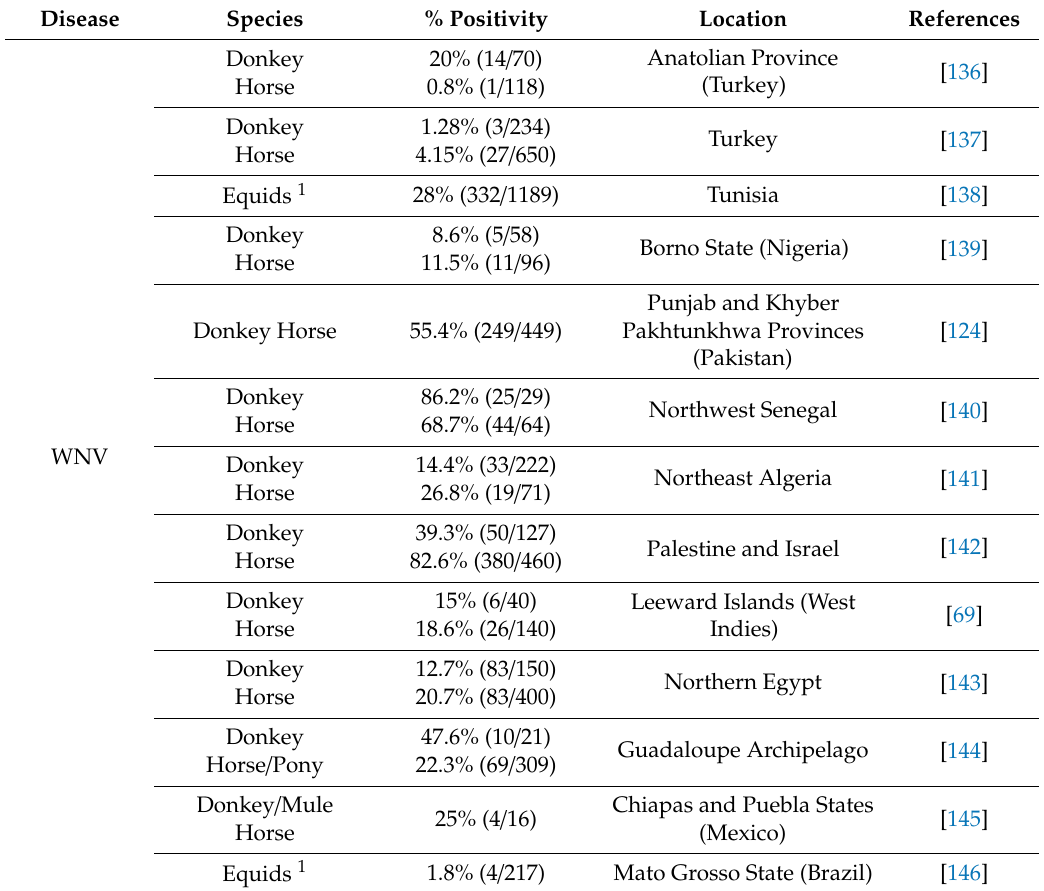
Table 6. West Nile virus (WNV) seroprevalence studies that include donkeys and / or mules. Disease Species %